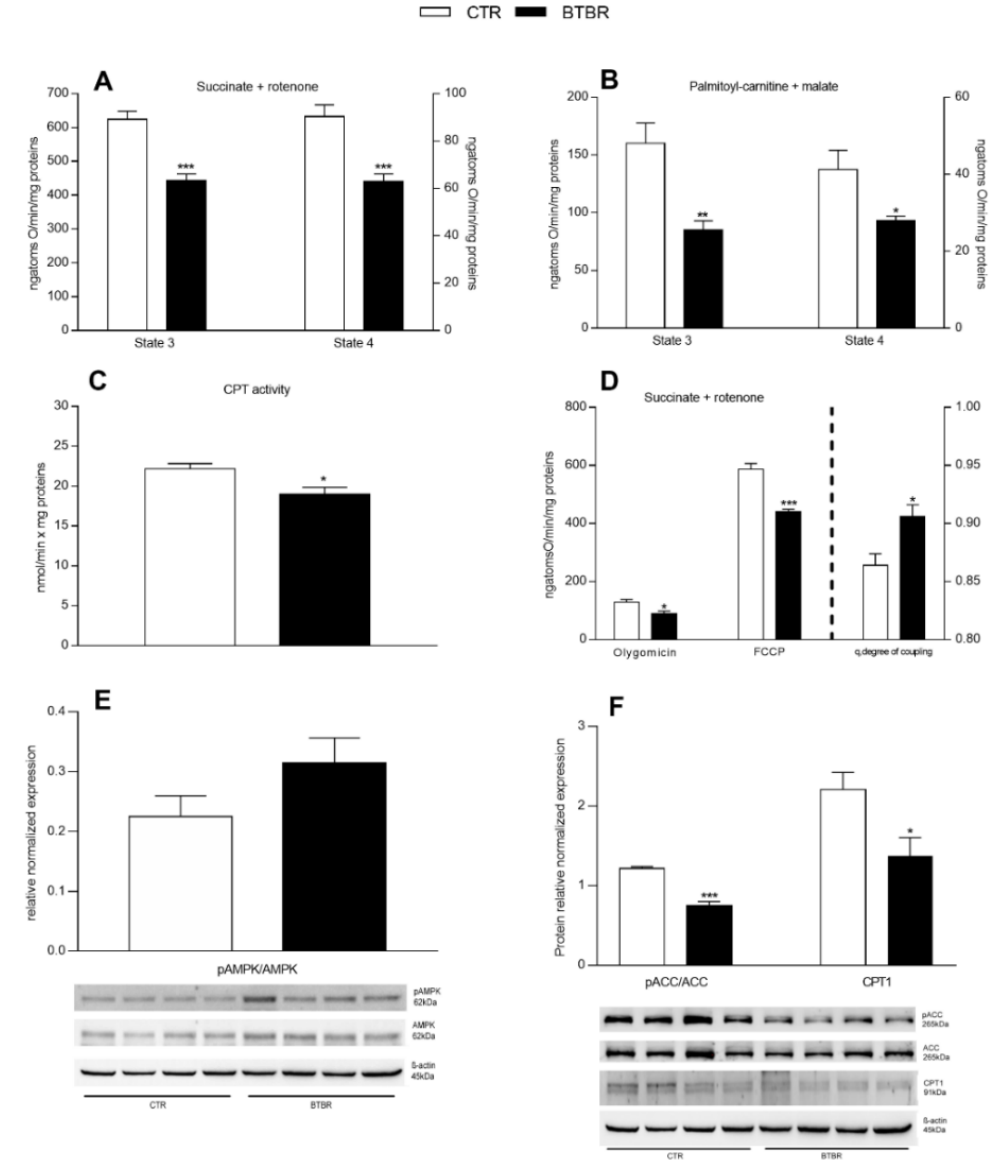
Figure 6. Hepatic mitochondrial function and efficiency, AMPK/ACC and CPT1 expression in control and BTBR mice. Hepatic mitochondrial respiration rates were evaluated with succinate + rotenone ( A ) or palmitoyl-carnitine + malate ( B ) as substrates. CPT activity was measured in isolated mi- tochondria ( C ). Mitochondrial oxygen consumption in the presence of oligomycin, uncoupled by carbonyl-cyanide-4(trifluoromethoxy)phenylhydrazone (FCCP) and the degree of coupling ( D ) were shown. Hepatic expression levels of phosphorylated adenosine-monophosphate-activated protein kinase- α (pAMPK), as ratio pAMPK/AMPK ( E ), phosphorylated acetyl-CoA-carboxylase (pACC) as ratio pACC/ACC, and carnitine-palmitoyl-transferase 1 (CPT-1) ( F ). n = 4. Data are presented as means ± SEM from n = 7 animals/group. * p < 0.05, ** p < 0.01, *** p < 0.001, BTBR vs. Control